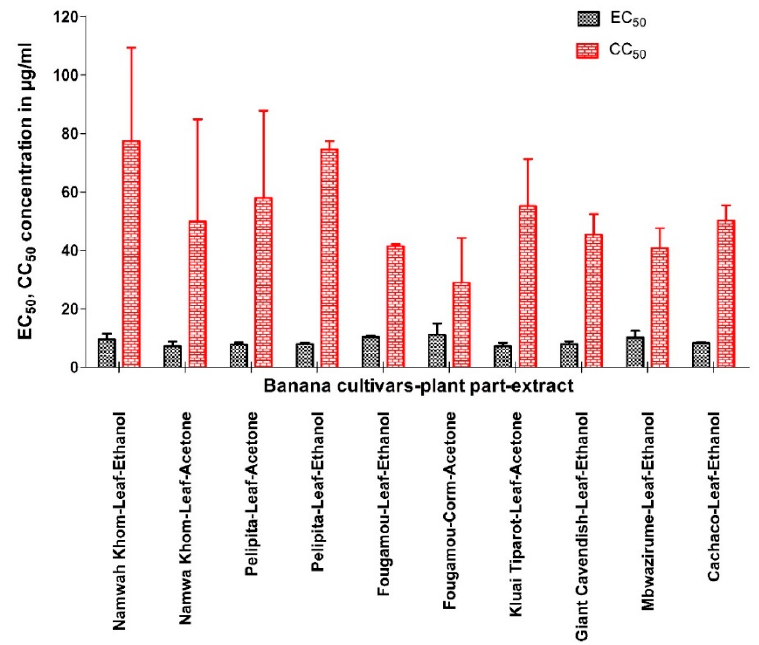
Figure 1. Comparison of EC 50 and CC 50 (mean ± SD) of selected banana cultivars-plant part-extract against Chikungunya virus. Table 2. Antiviral and cytotoxic activity of banana varieties against Chikungunya virus. Code